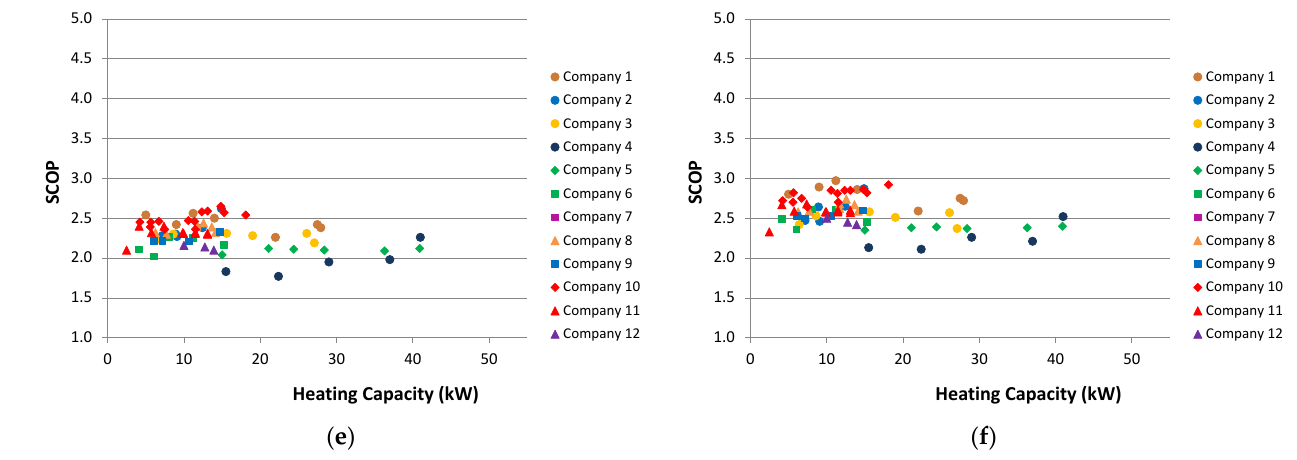
Figure 3. SCOP against HP’s heating capacity for the city of Ierapetra: ( a ) Τ w,outlet = 35 °C — without compensation, ( b ) Τ w,outlet = 35 °C — with compensation, ( c ) Τ w,outlet = 45 °C — without compensation, ( d ) Τ w, outlet = 45 °C — with compensation, ( e ) Τ w,outlet = 55 °C — without compensation, ( f ) Τ w,outlet = 55 °C — with compensation.